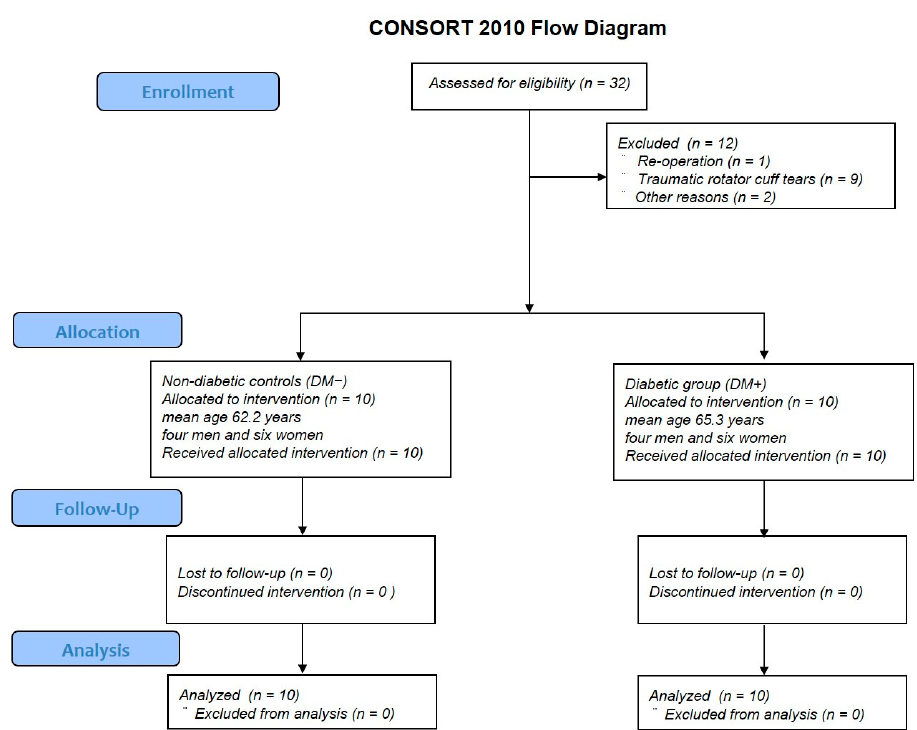
Figure 1. CONSORT flow diagram.